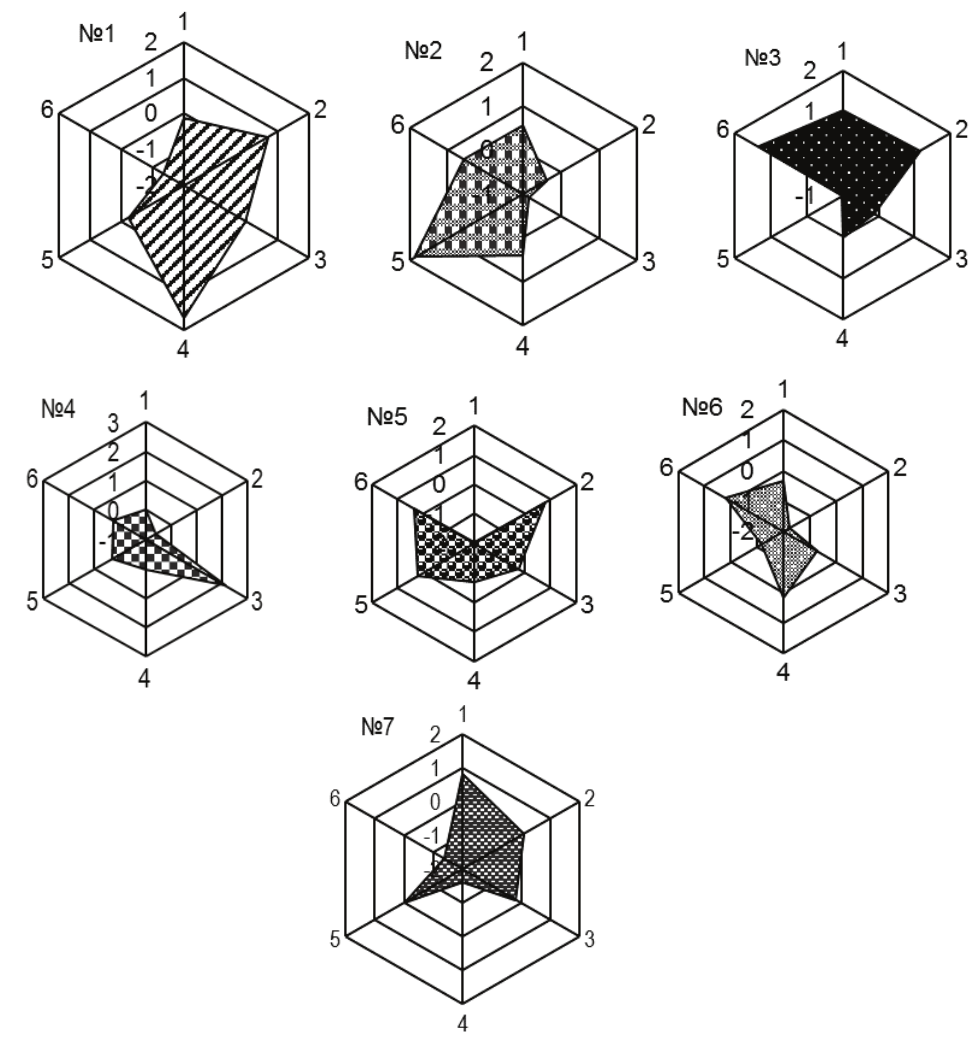
Fig. 5. Individual values of factors of athletes of team main staff: №№ 6,7 – forwards, №5 – back. Names of the factors: 1 – morphological functional development; 2 – strength of nervous system; 3 – special endurance; 4 – speed power qualities; 5 – vegetative regulation; 6 – speed abilities (0 corresponds to average expressiveness of the factor); negative values correspond to factor’s expressiveness below average; positive values – to level above